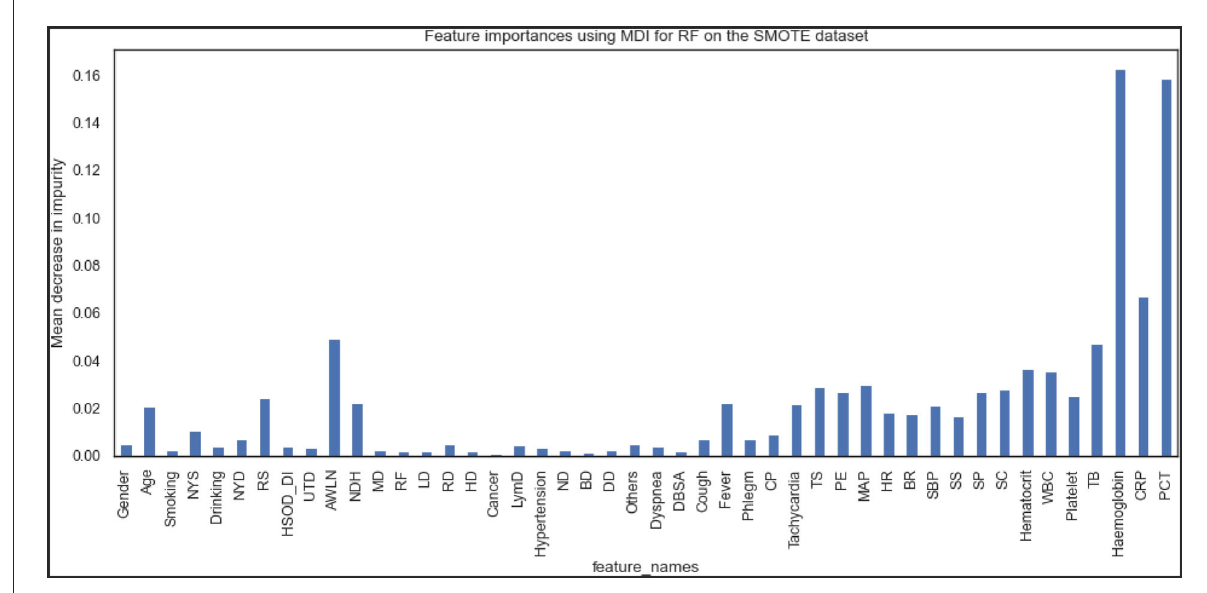
FIGURE10 Feature importance according to the RF model on the SMOTE dataset.